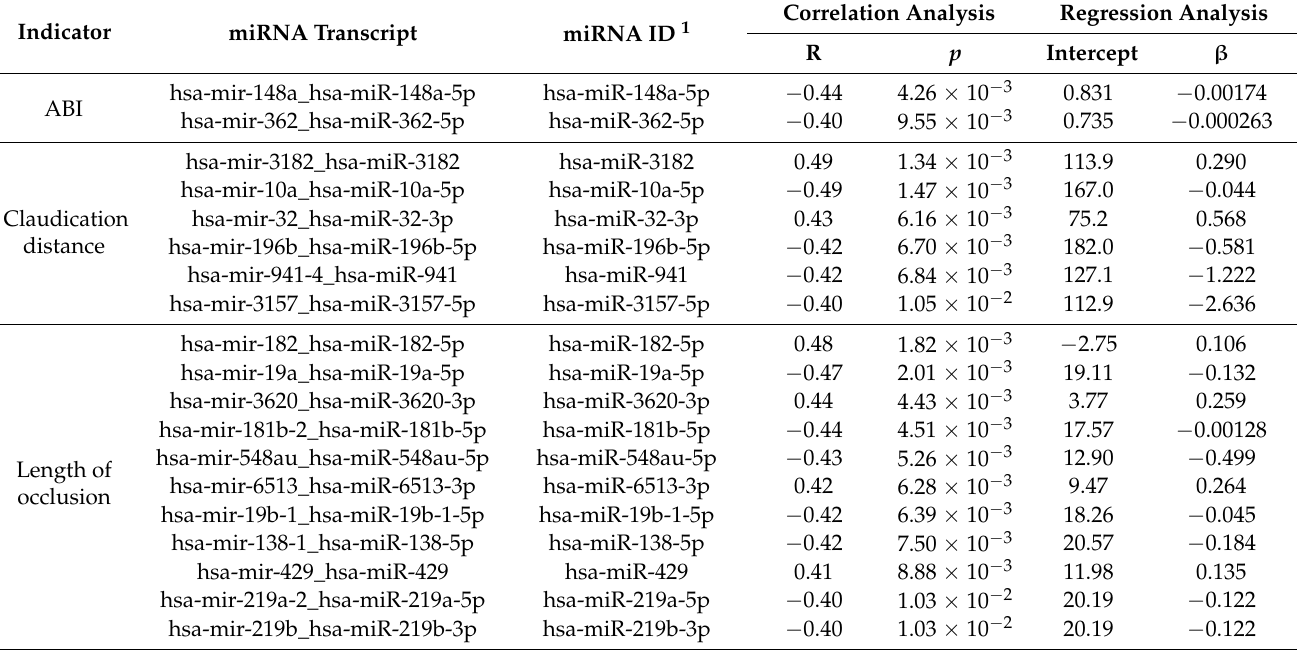
Table 2. Results of the correlation analysis and multivariate linear regression analysis performed between the clinical indicators of LEAD (ABI, claudication distance, and length of occlusion) and miRNA expression in PBMCs of LEAD patients. The table presents results obtained for 19 miRNAs selected from the correlation analysis with the absolute value of Spearman correlation coefficient ≥ 0.4, p value < 0.05, and the average number of normalized counts above 10. Correlation Analysis Regression miRNA Transcript miRNA ID 1